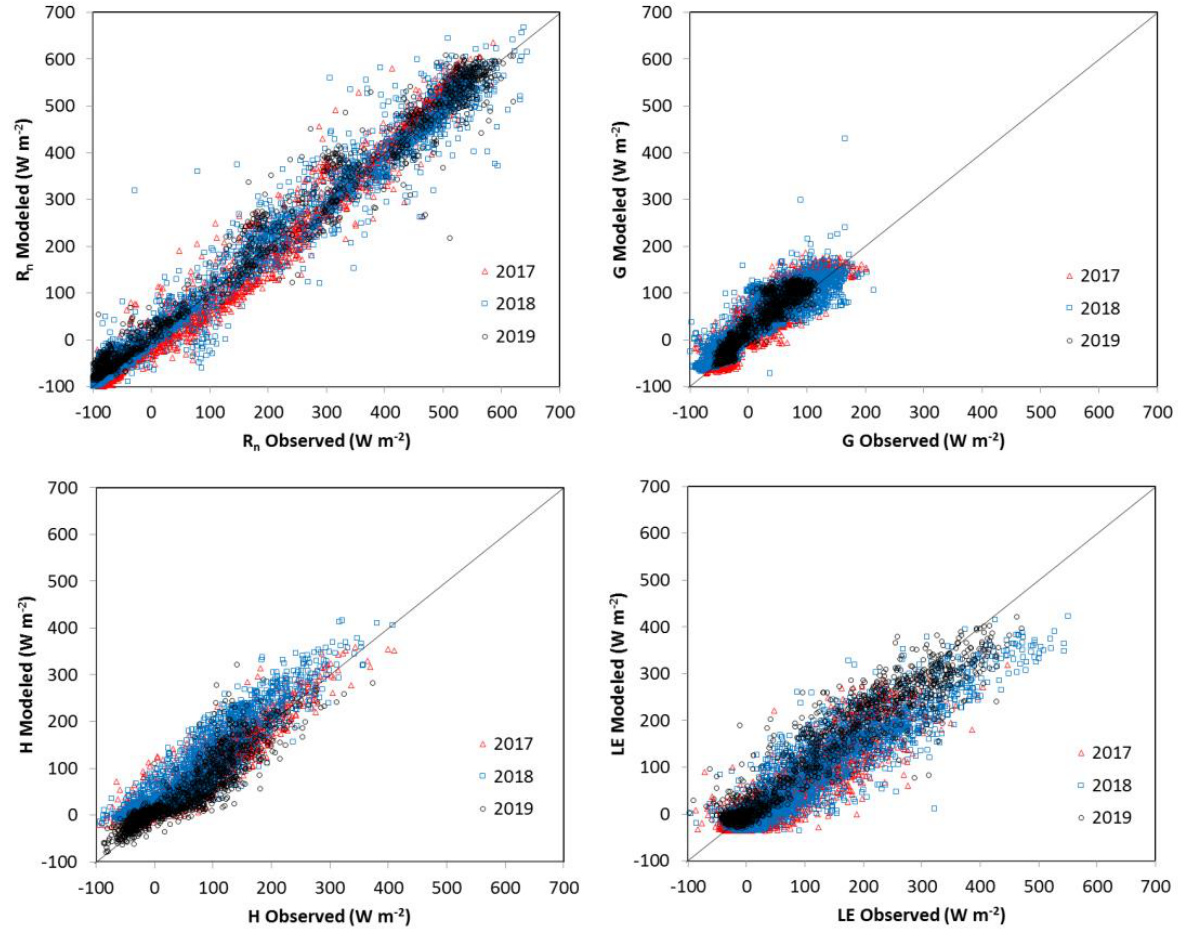
Figure 6. Linear regressions between the hourly averaged surface energy fluxes estimated by the STSEB model versus their corresponding ground measured values: net radiation (R n ), soil heat flux (G), sensible heat flux (H), and latent heat flux (LE). Residual technique was applied to force the EB closure. Table 2. Statistics of the linear regressions between modeled and observed hourly values of the